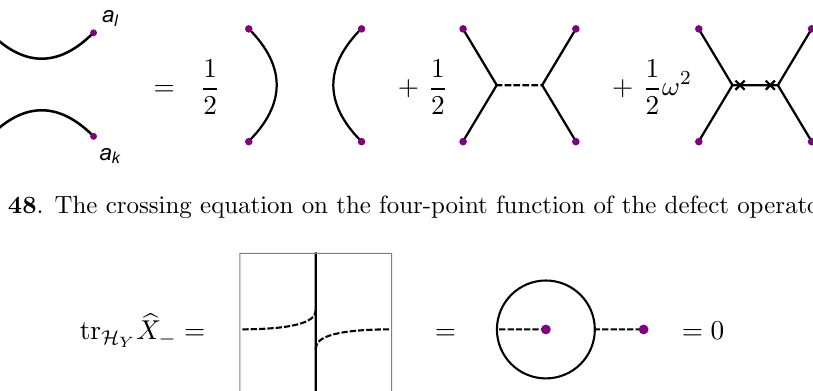
tr X = = = 0 (cid:0) H Y b